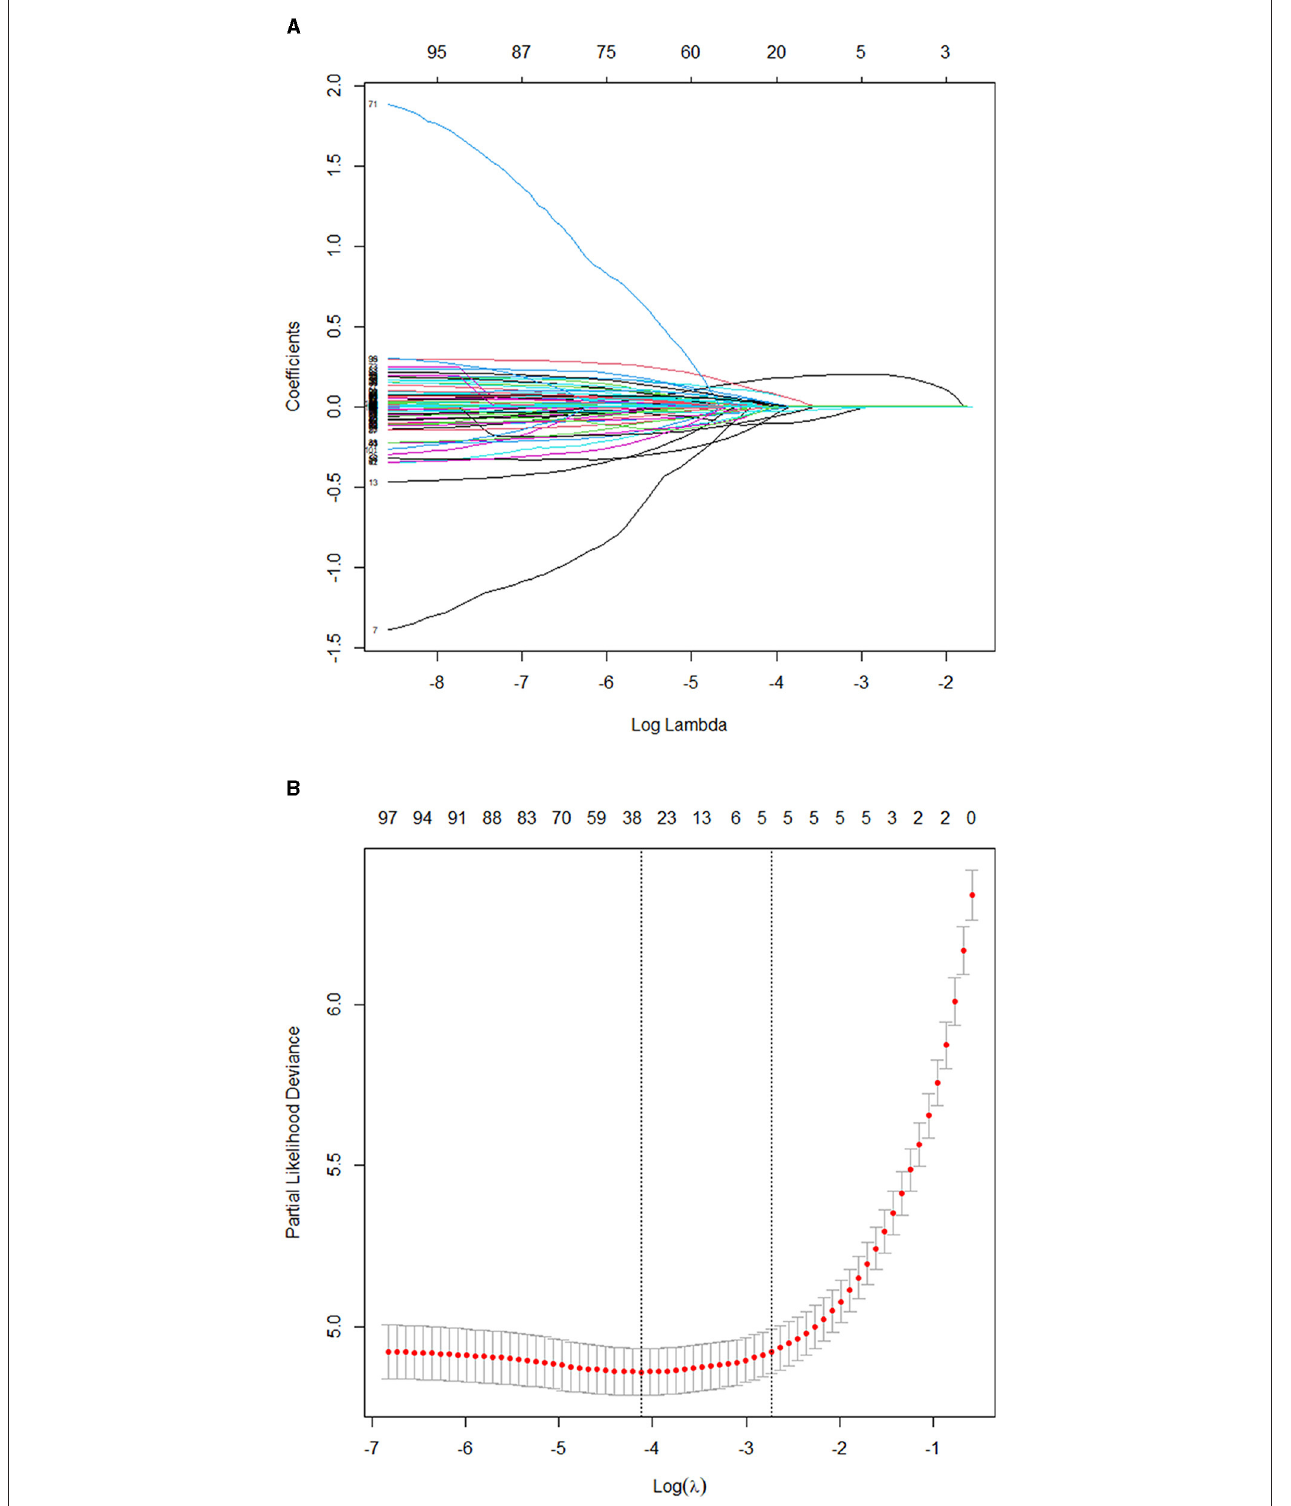
FIGURE 3 | (A) Results of the Lasso regression. (B) Results of the 10-fold cross-validation. Consequently, five variables were selected for inclusion in the more concise prediction model within one standard error.